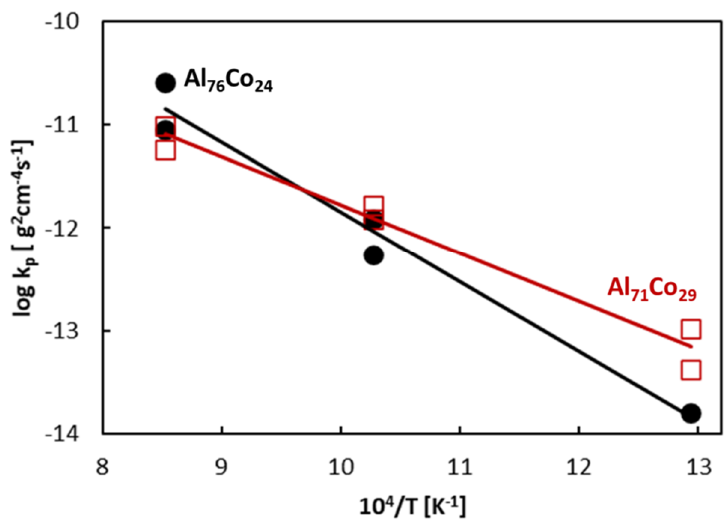
Figure 11. Temperature dependence of parabolic rate constants of the Al-Co alloys.